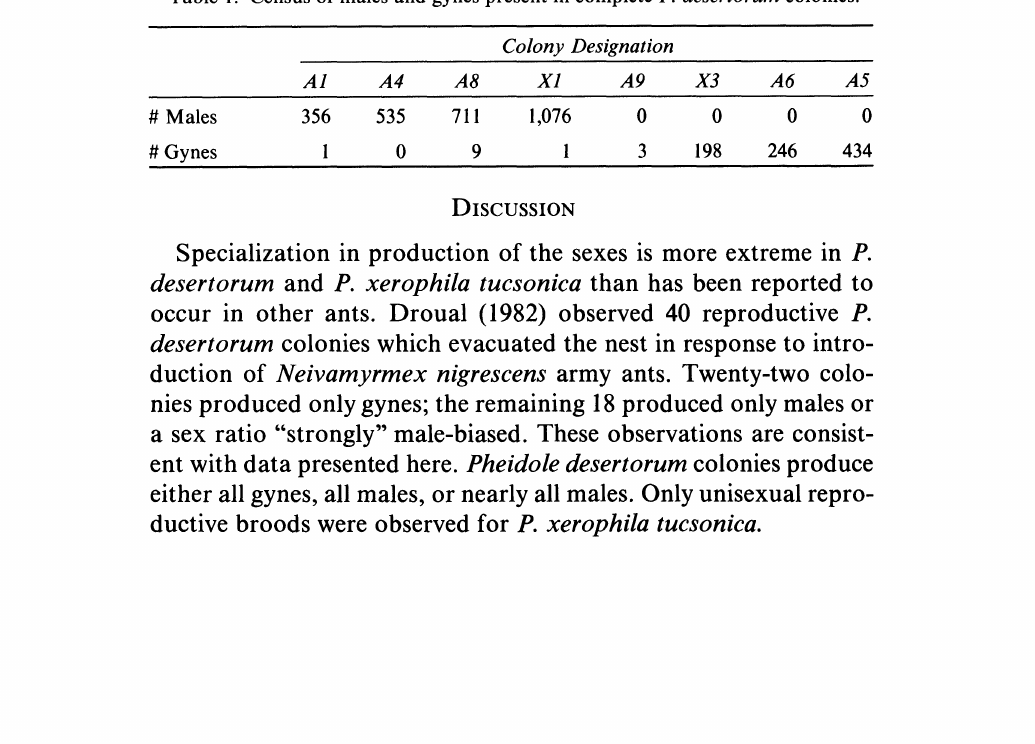
Table 1. Census of males and gynes present in complete P. desertorum colonies. Colony